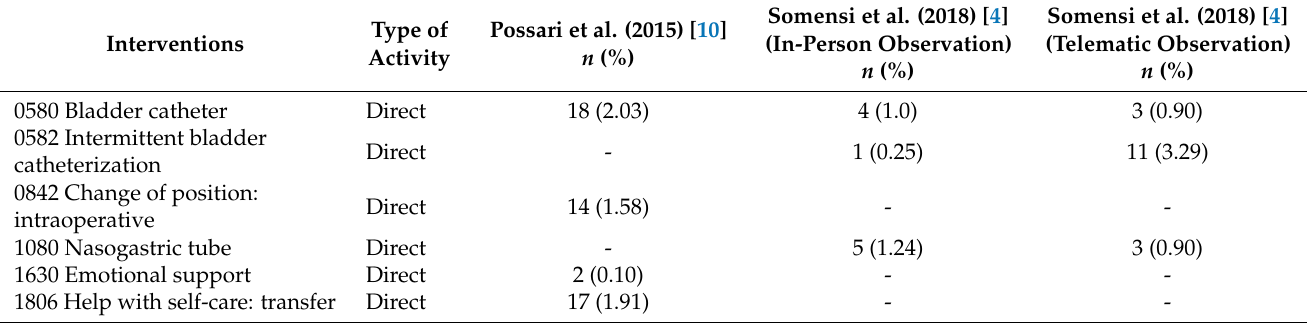
Table 4. Prevalence of interventions identified in the studies in numerical or alphabetical